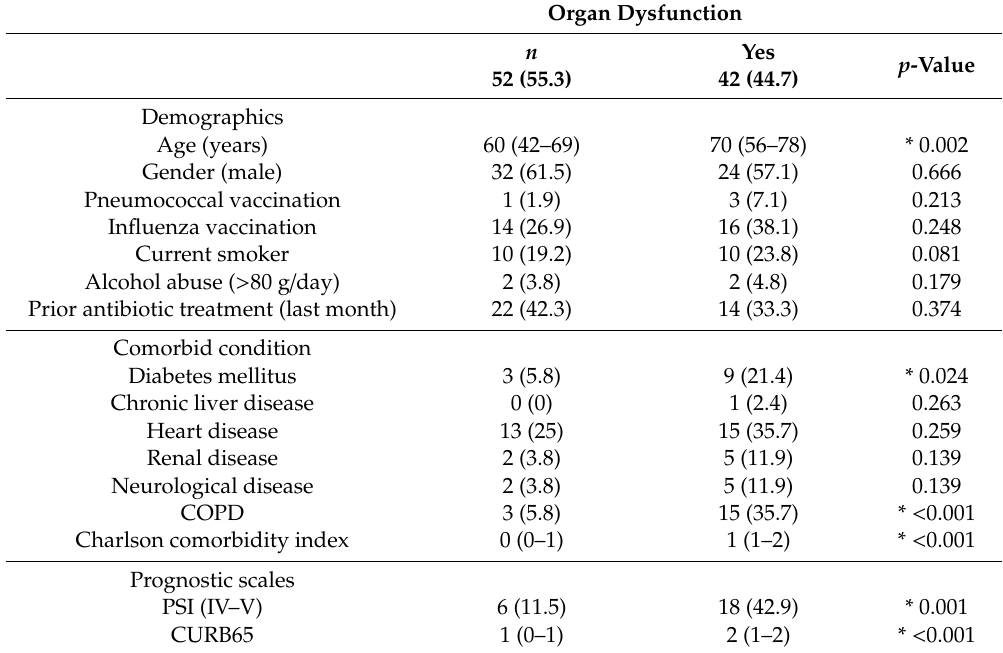
Table 1. Demographic characteristics, comorbid conditions and prognostic scales in community- acquired pneumonia (CAP) according to organ